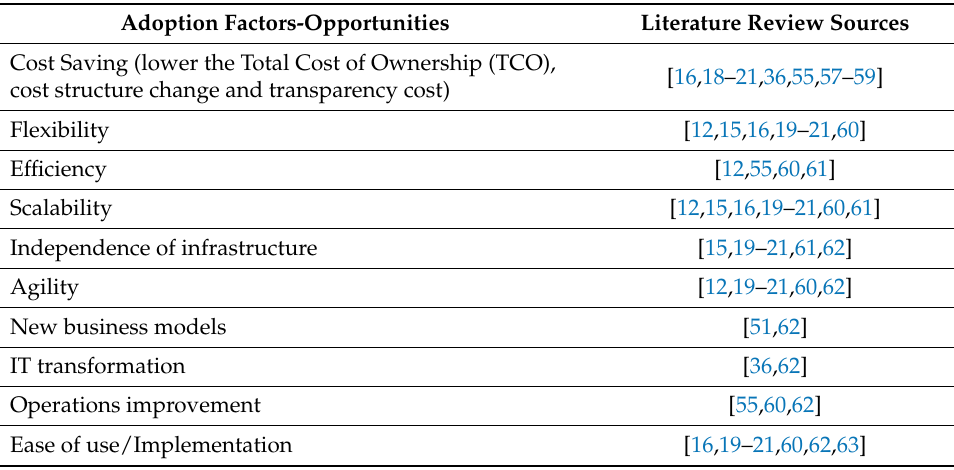
Table 2. Adoption factors–opportunities and literature review